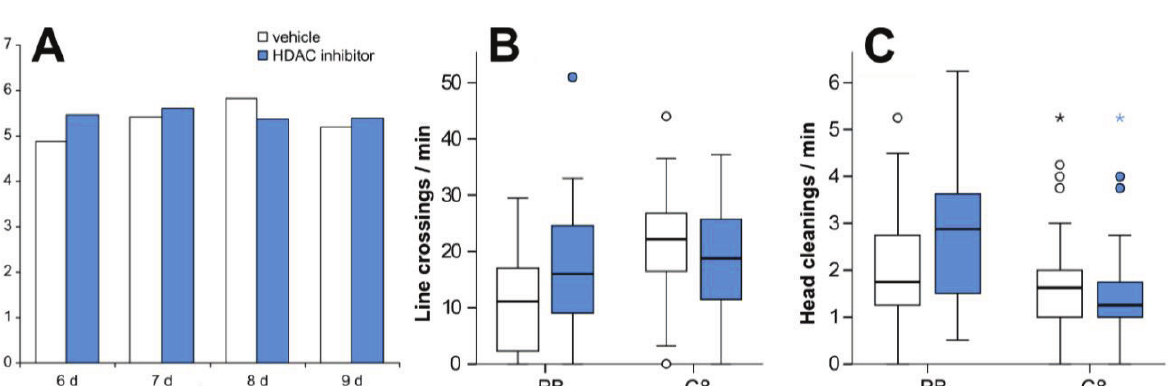
Figure 6. HDAC inhibitor treatment does not affect sucrose sensitivity or locomotor activity. Sucrose sensitivity ( A ): treatment with an HDAC inhibitor does not significantly alter sucrose sensitivity indices at age 6, 7, 8 or 9 d ( p > 0.05). 10 mM C8 was used to test 6, 8 and 9 d bees, 10 mM PB was used to test 7 d bees. Mean sucrose sensitivity indices are shown. From left to right, n HDAC inhibitor = 52, 36, 63 and 40; n vehicle = 56, 56, 60 and 51. Locomotor activity ( B , C ): bees treated with HDAC inhibitor show no significant change in movement rate ( B ) or grooming behaviour ( C ) relative to controls. By experiment, PB: n HDAC inhibitor = 28; n vehicle = 28; C8: n HDAC inhibitor = 37; n vehicle = 38. PB bees were 7 d old, C8 bees were 8 d old. Box plots show medians, quartiles and ranges, statistically significant effects of PB or C8 treatment were detected on average number of line crossings per minute ( p = 0.719, 0.254 respectively) or average number of head cleanings per minute ( p = 0.718, 0.197